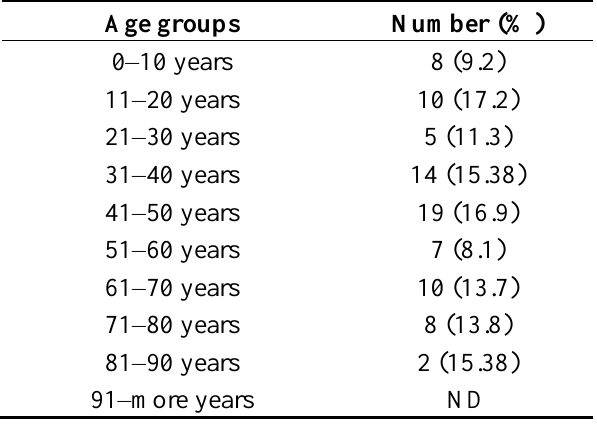
Table 1. Seroprevalence in relation to age groups.